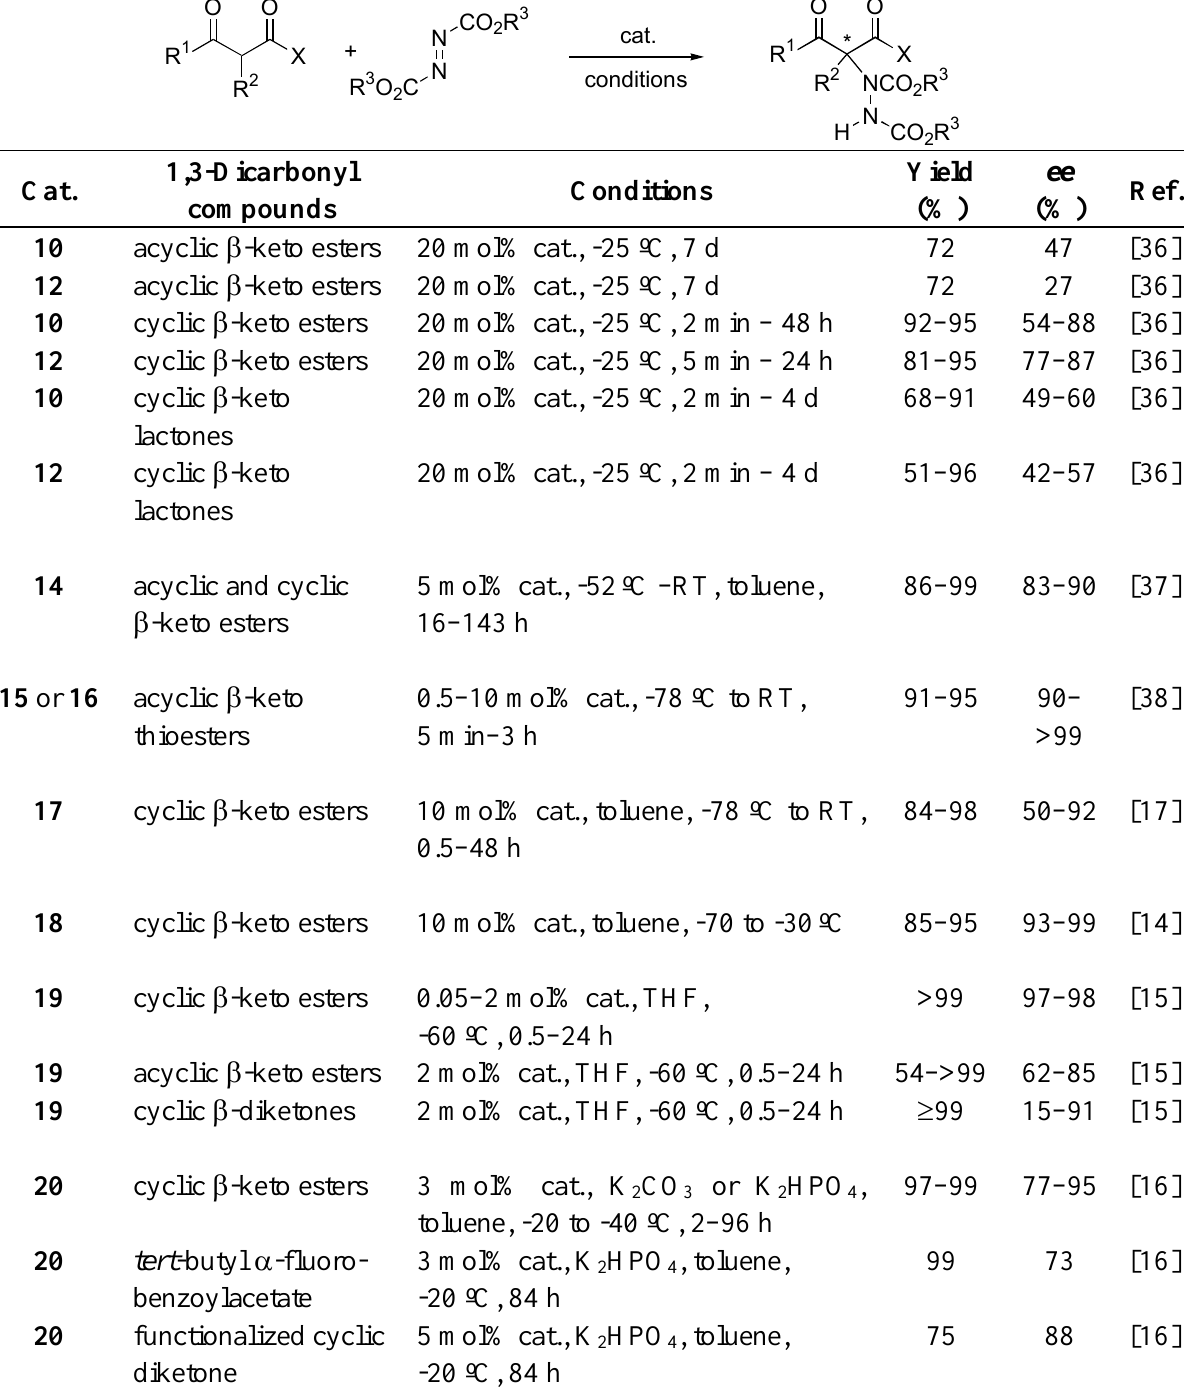
Table 4. Enantioselective  -amination of 1,3-dicarbonyl compounds with various